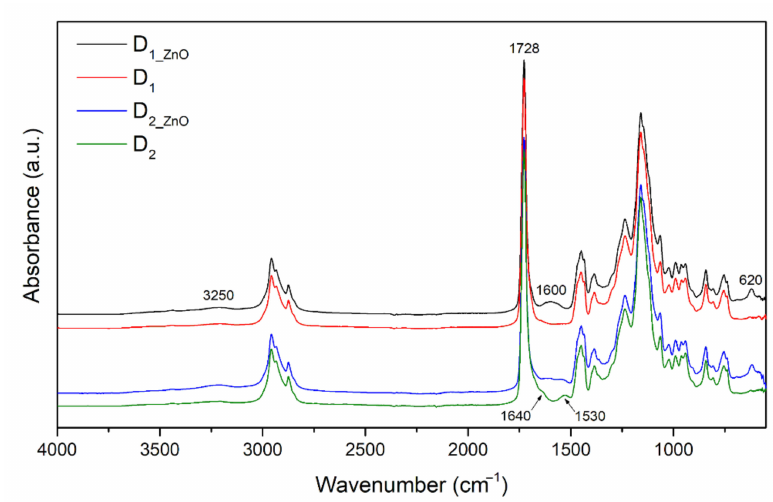
Figure 1. FT-IR spectra of D-labelled latex coatings of Series 1 and Series 2.